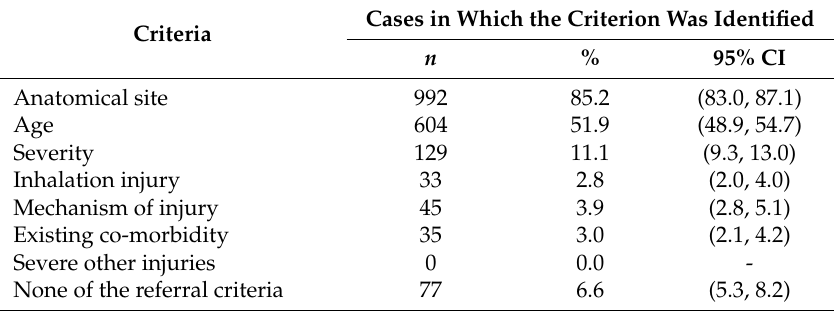
Table 2. Proportion of cases for which a given criterion was identified ( n = 1165).